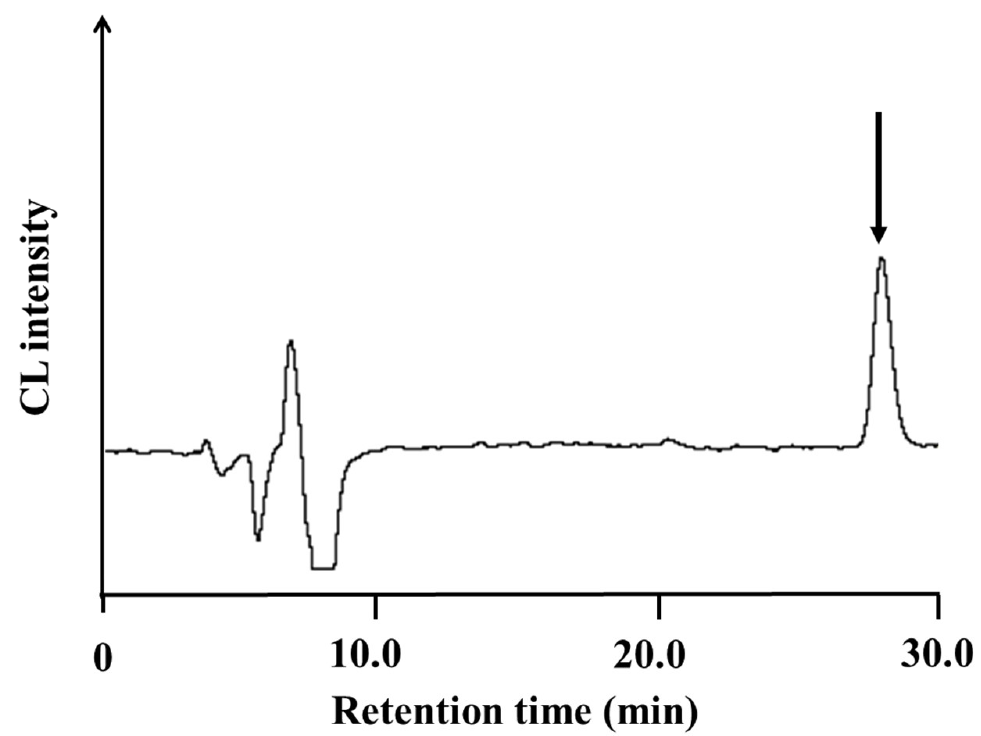
Figure 8. Chromatogram of UQ in human plasma by CL detection after electrolytic reduction. The peak indicated by the arrow corresponds to UQ. Table 4. The recovery and precision of UQ determination in spiked human plasma employing the proposed electrolytic reduction